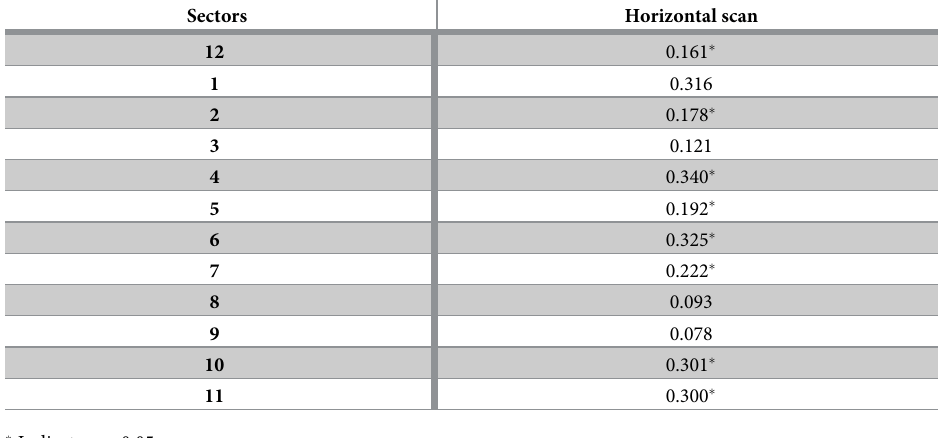
Table 5. Correlation values between the retinal nerve fibre layer thickness repeatability and age for the optic disc